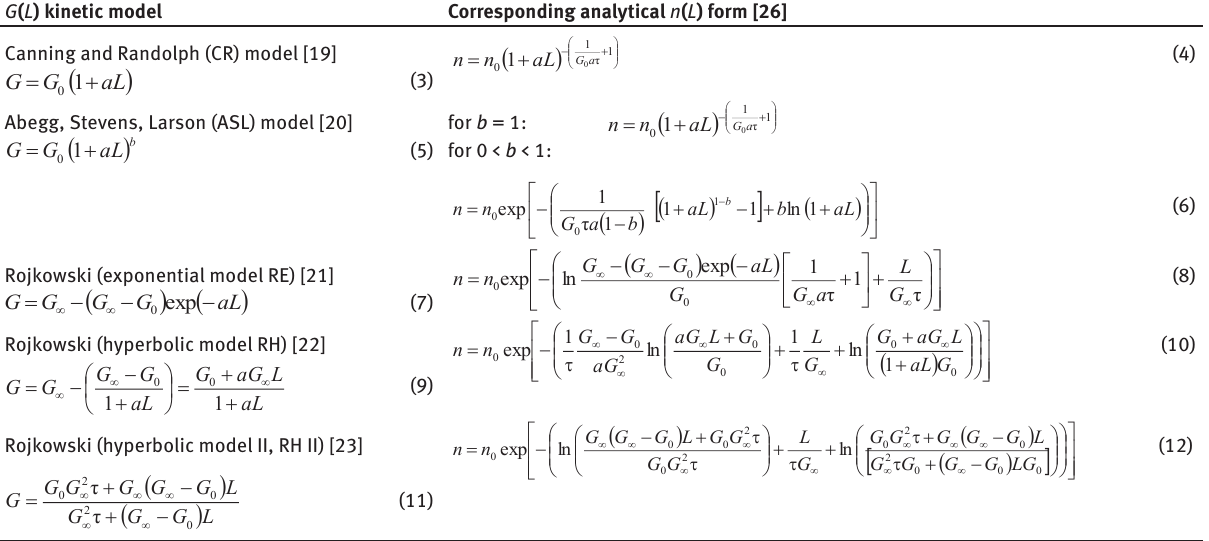
Table 2: Size–dependent growth G ( L ) kinetic models and corresponding analytical n ( L ) forms. G ( L ) kinetic model Corresponding analytical n ( L ) form G ( L ) kinetic model Corresponding analytical n ( L ) form [26] Canning and Randolph (CR) model [19]